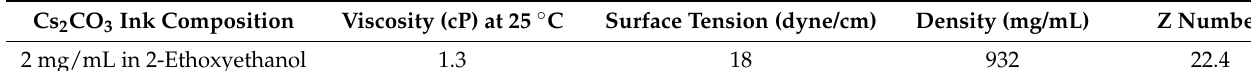
Table 1. Physical properties of the Cs 2 CO 3 ink.